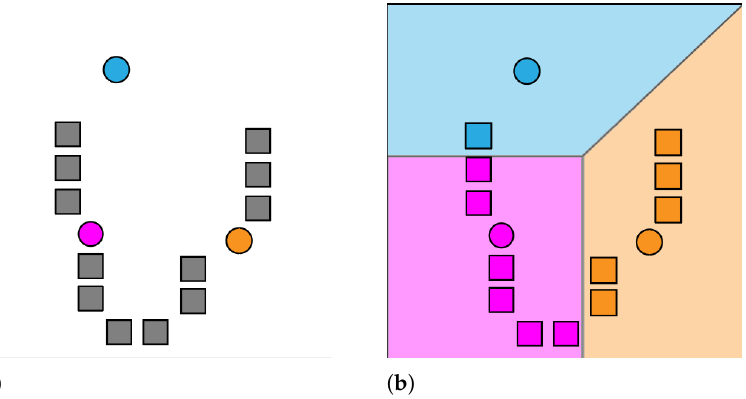
Figure 2. K-Means assignment step. ( a ) k initial means are randomly generated, k = 3; ( b ) k clusters are created by associating observations with the nearest mean clustering.